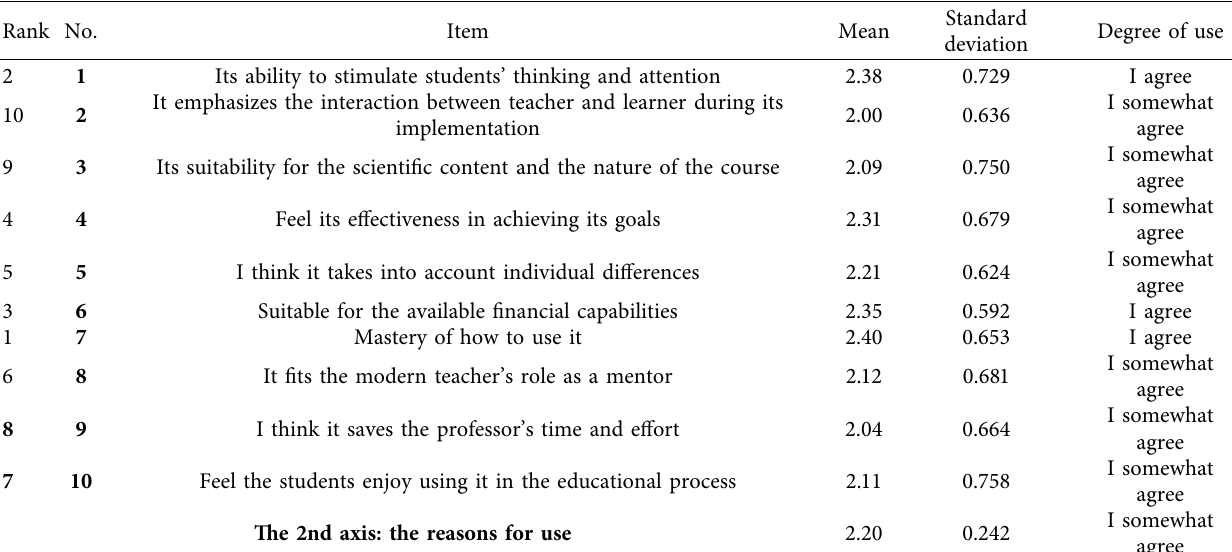
The first axis: the degree to which the UOH staff use MTM The averages for the items of this axis were 1.23–2.62. Table 6: The averages and standard deviations of the paragraphs of the questionnaire in the 2 nd axis: the reasons for the use. Rank No.